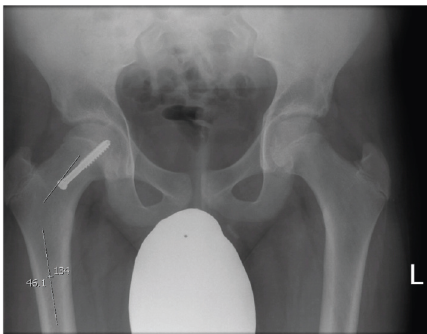
Figure 4: Neck shaft angle. A longitudinal line is drawn down the centre of the femoral neck. The angle between a longitudinal line down the shaft of the femoral neck and the shaft of the femur is measured. This angle represents the neck shaft angle.